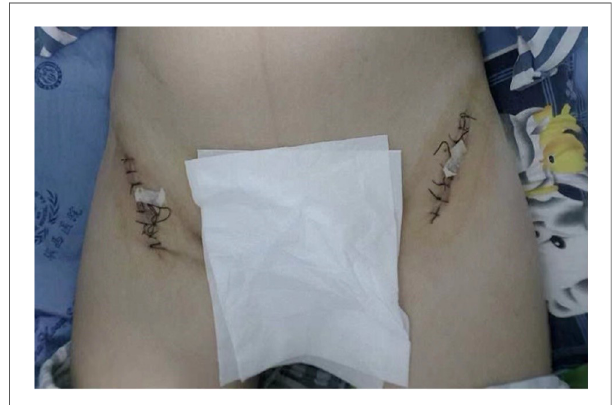
FIGURE 2 Postoperative direct anterior surgical incision over the bilateral femoral head with suture threads and rubber drainage in situ